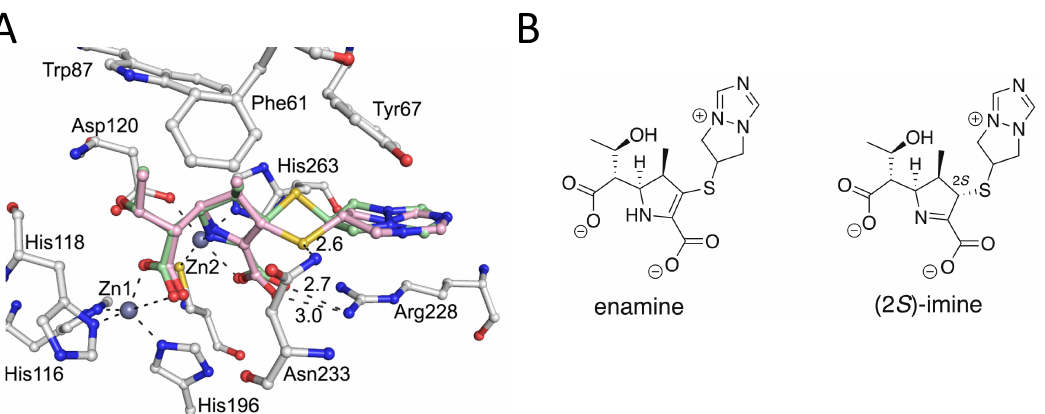
Figure 4. Views of a crystal structure of VIM-2 complexed with biapenem-derived ligands (PDB 6Y6J). ( A ) Interactions occurring between the ( 2S )-imine (green) and enamine (pink) products at the VIM-2 active site. Note that both products interact via their C3 carboxylate with Arg228 and that the sulfur of the thioether sidechain of the enamine is positioned adjacent to the primary amide of Asn233. ( B ) The ( 2S )-imine and enamine tautomers were each modelled at 50% occupancy.